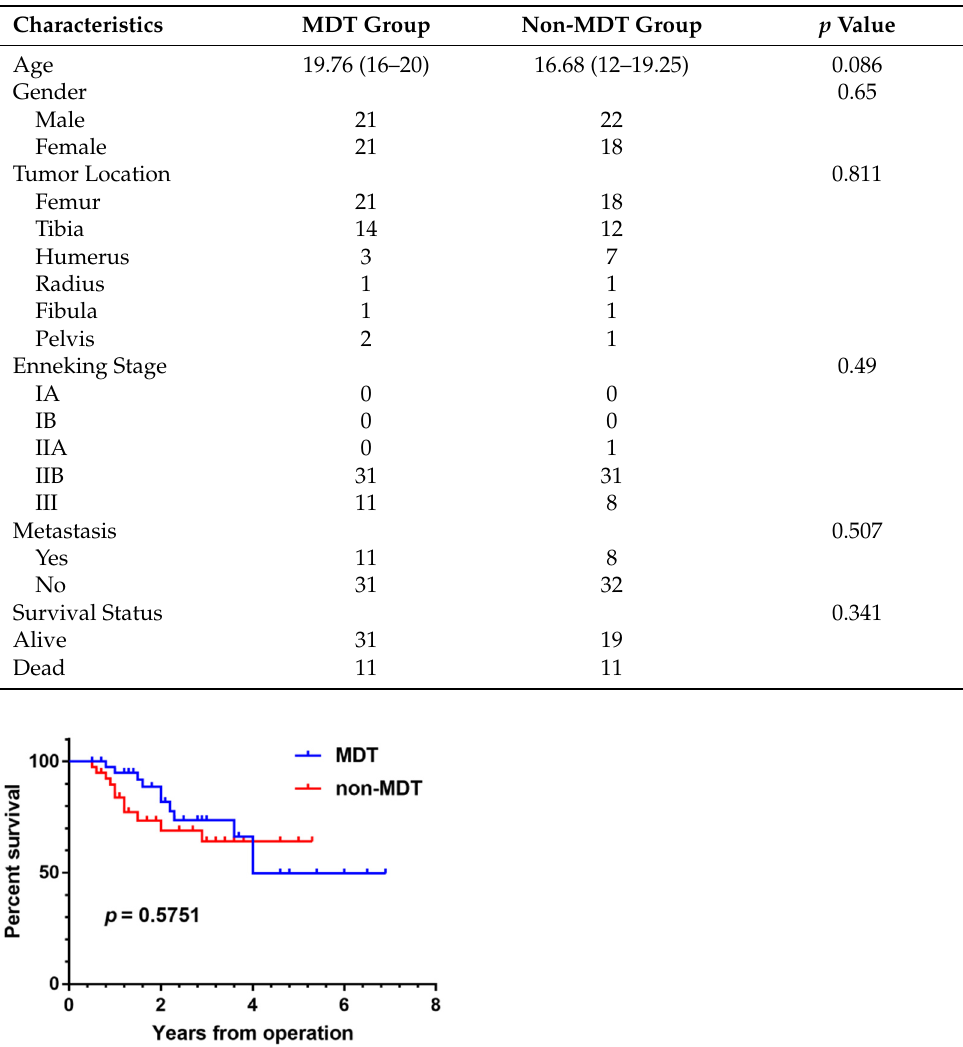
Table 8. Patient characteristics.